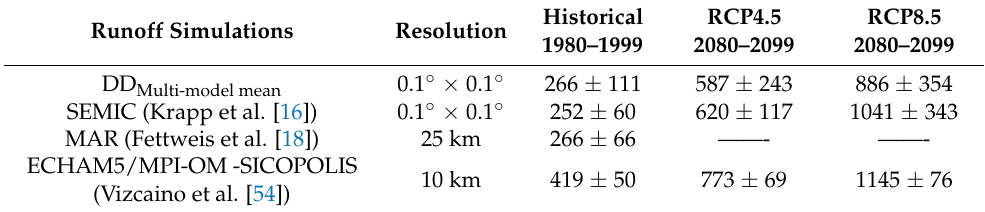
Table 3. Mean and standard deviation of modeled runoff by DD methods and SEMIC, and compar- isons with different studies under historical and RCP scenarios (Gt yr − 1